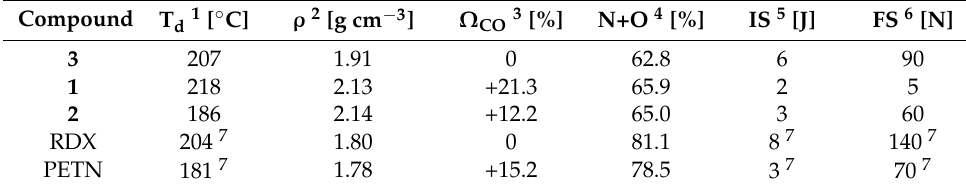
Table 1. Comparison of physicochemical parameters of the compound 3 with known energetic materials.